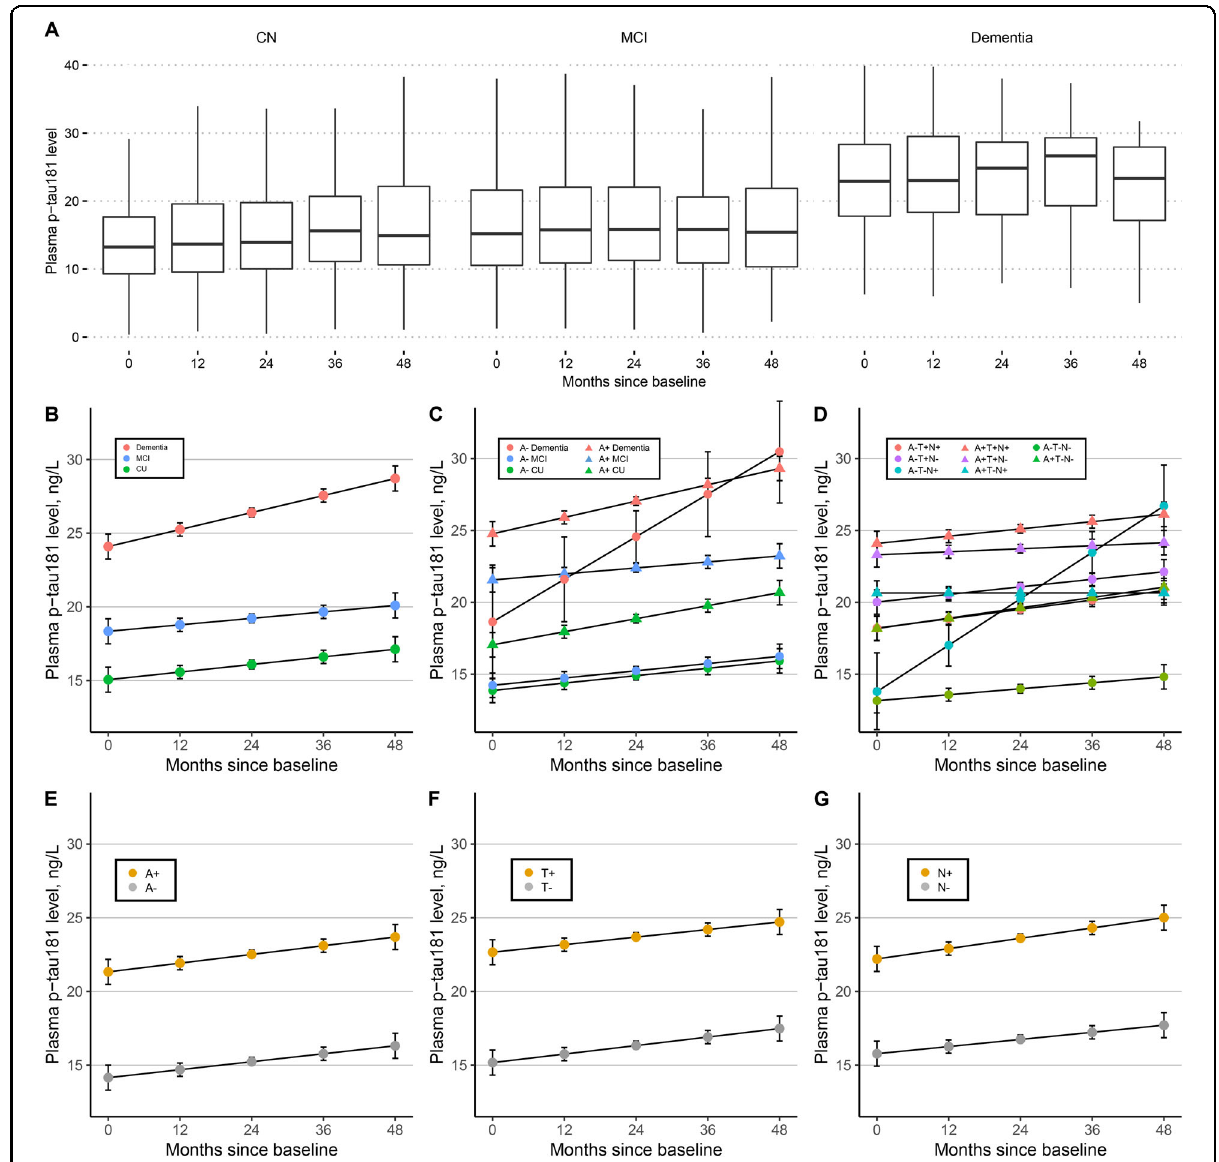
Fig. 1 Plasma p-tau181 levels by diagnostic group, A β -status, and ATN classi fi cation. ( A ) Observed data in different diagnostic groups; Estimated plasma p-tau181 trajectories by diagnosis ( B ), by diagnosis and A β status ( C ), by ATN classi fi cation ( D ); Estimated plasma p-tau181 trajectories by A status ( E ), by T status ( F ), and by N status ( G ). A β β -amyloid; A amyloid; T tau pathology; N neurodegeneration; p-tau phosphorylated tau; CN cognitive normal; MCI mild cognitive